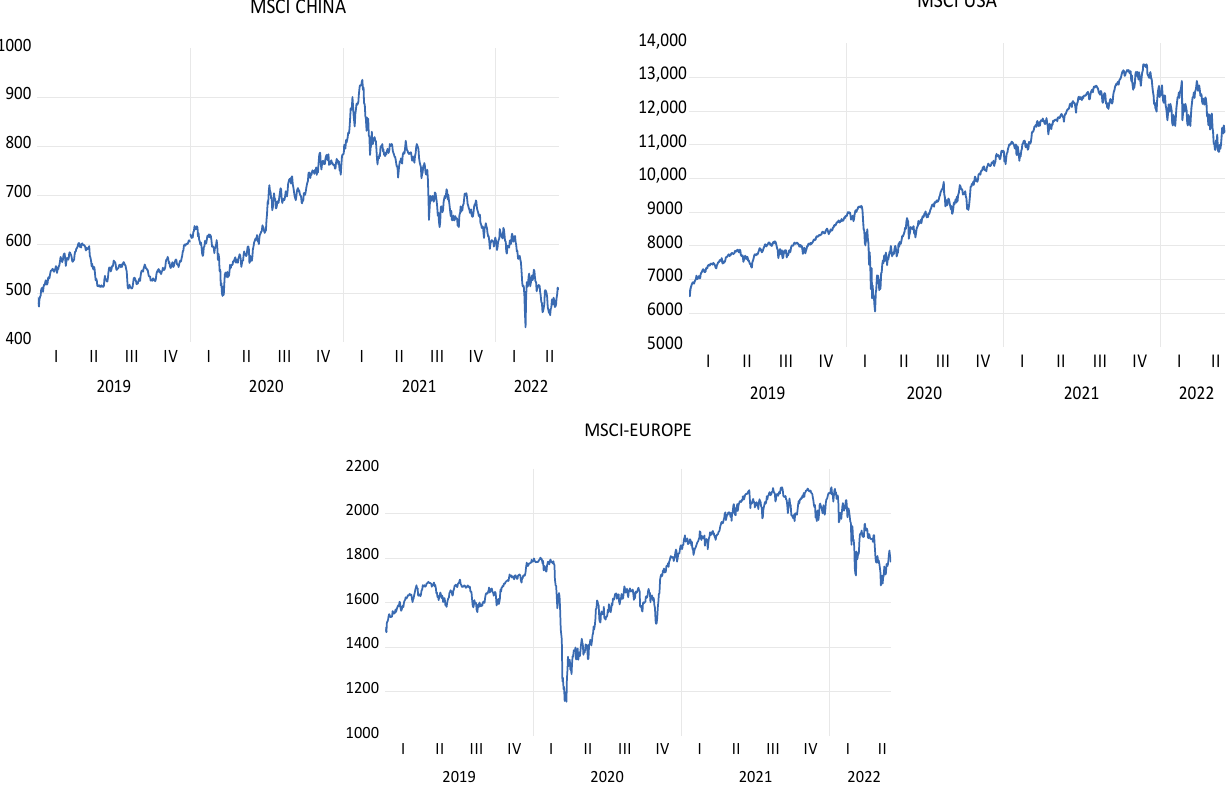
Figure 1. Evolution of the values of the stock market indices.